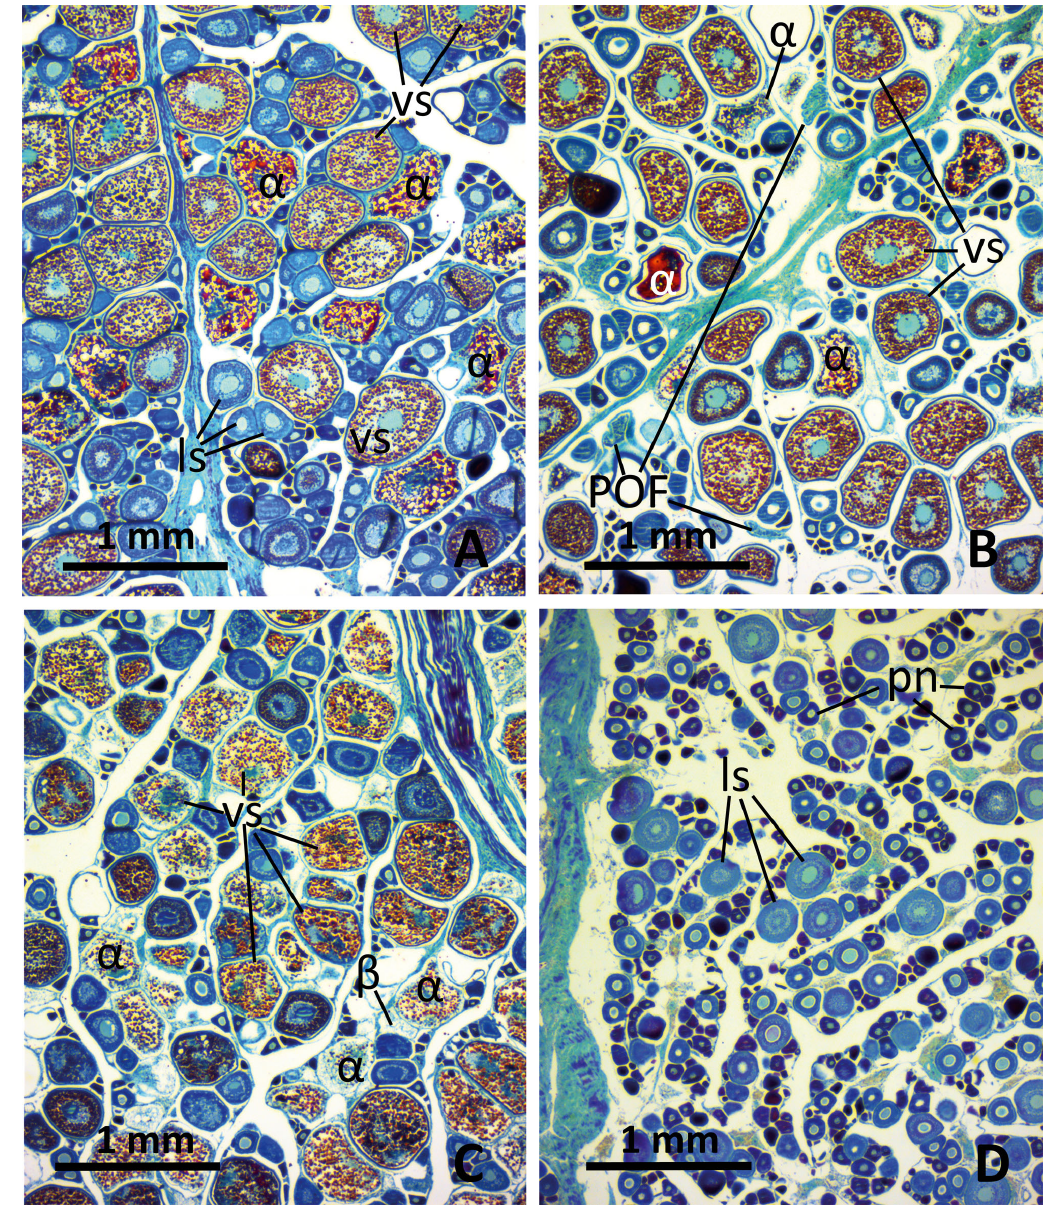
Fig. 2. Micrographs of Atlantic bluefin tuna Thunnus thynnus ovaries at the 4 developmental stages identified in this study: (A) active nonspawning (ANS); (B) active spawning (AS); (C) inactive mature (IM); (D) resting (R). ls: lipid-stage oocyte; pn: peri - nucleolar oocyte; POF: postovulatory follicle; vs: vitellogenic oocyte; α : α -atretic follicle; β : β -atretic follicle. Haematoxylin- VOF